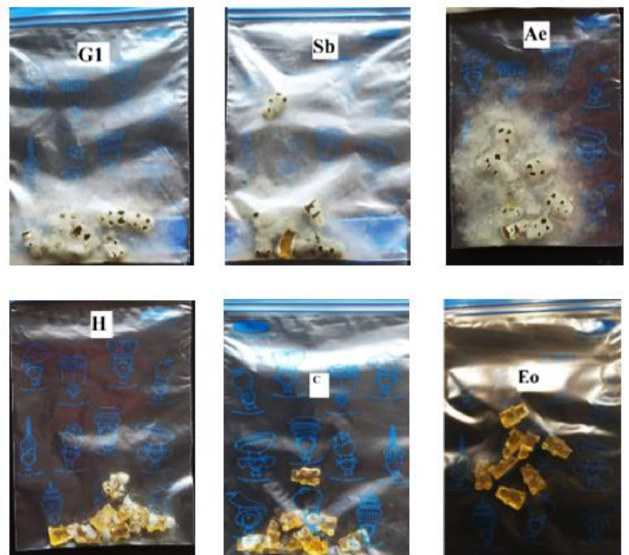
Figure 3. Mold growth on chewable gel tablets (G1, Sb, Ae, H, C, and Eo) after 52 days, n = 8 (number of tablets in the plastic